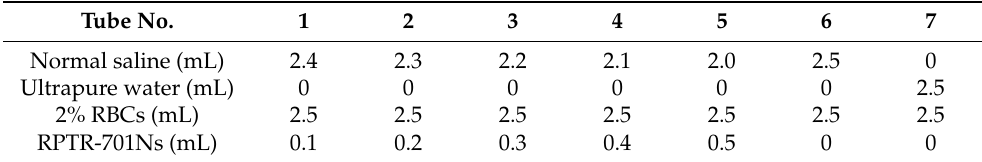
Table 1. Hemolysis Test of